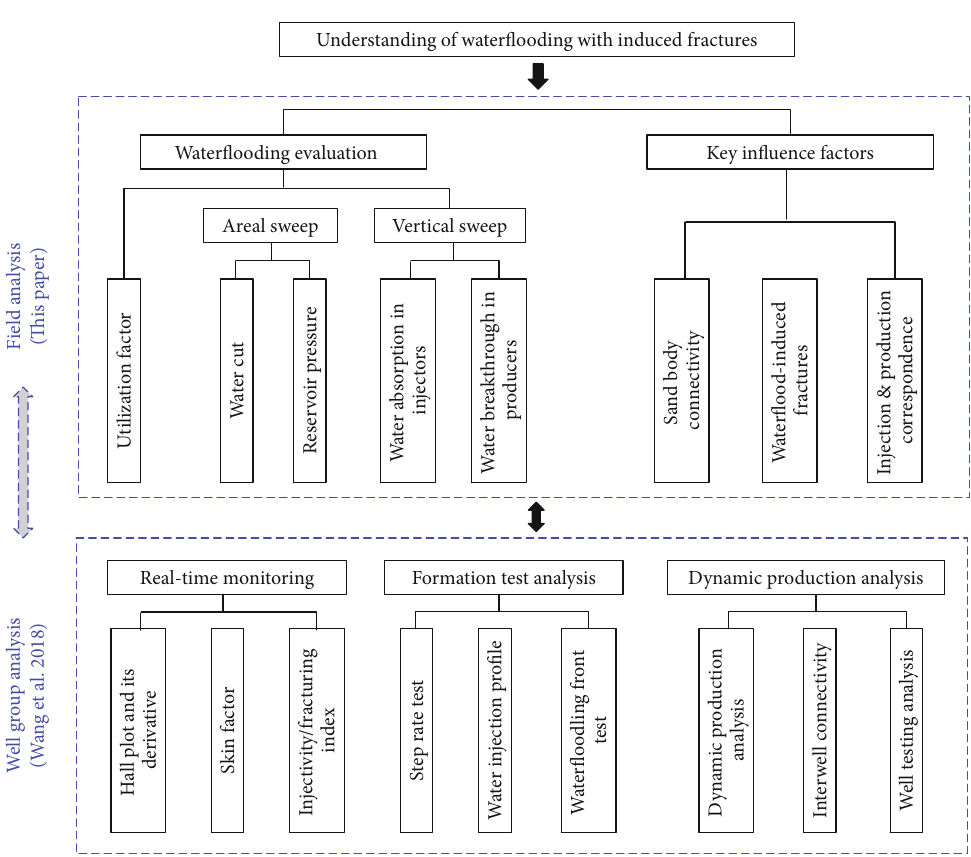
Figure 1: Integrated method for the understanding of water fl ooding with the in fl uence of induced fractures.